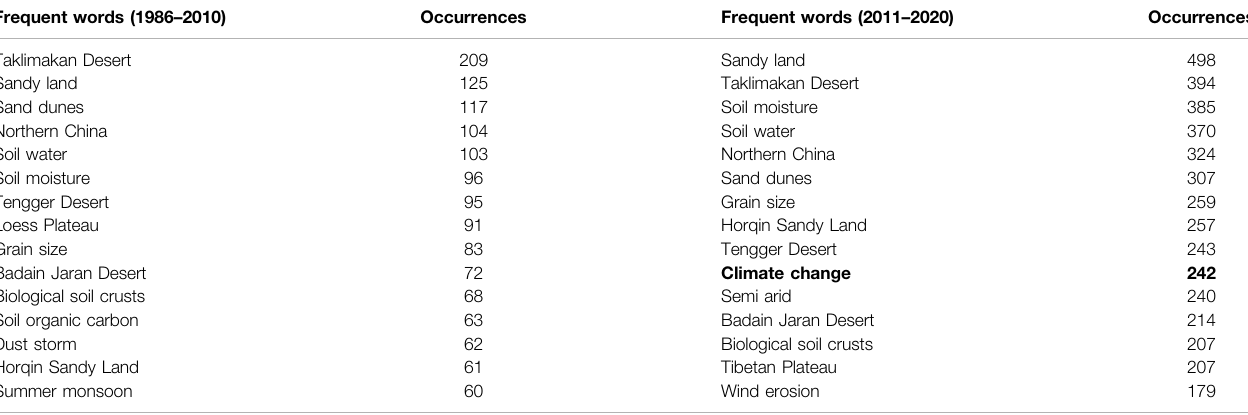
TABLE 1 | The 15 most frequent words within two main time periods (i.e., 1986 to 2010 and 2011 – 2020). Frequent words (1986 – 2010)